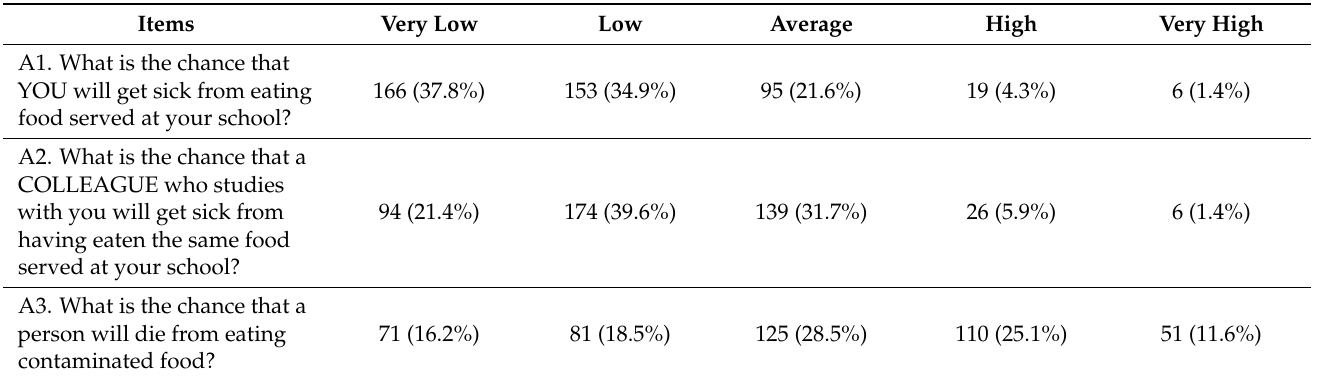
Table 2. Relative and absolute frequencies of items refer to the “probability” dimension (A1 and A2) and the perception of lethality (A3) of the risk perception questionnaire.